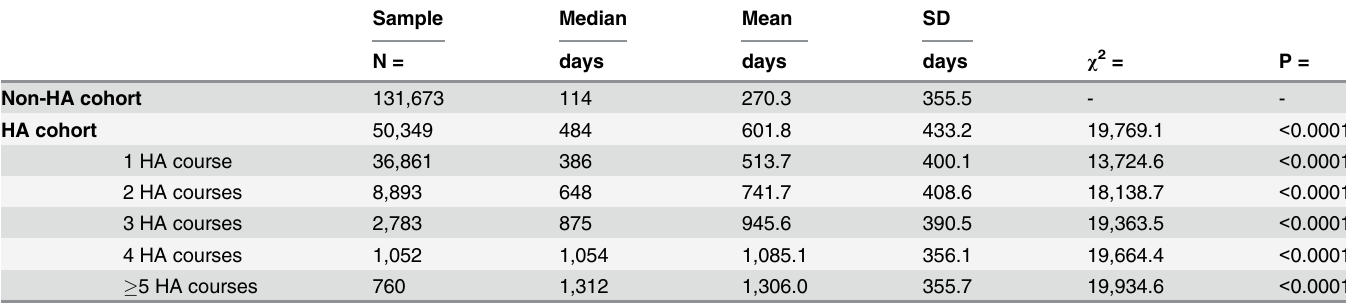
Table 3. Timing of total knee replacement (TKR) for all patients. Patients in the HA cohort got a TKR on average 601.8 days after OA diagnosis, which is significantly longer than the mean time-to-TKR of 270.3 days in patients who did not receive HA ( χ 2 = 19,769.1; p <